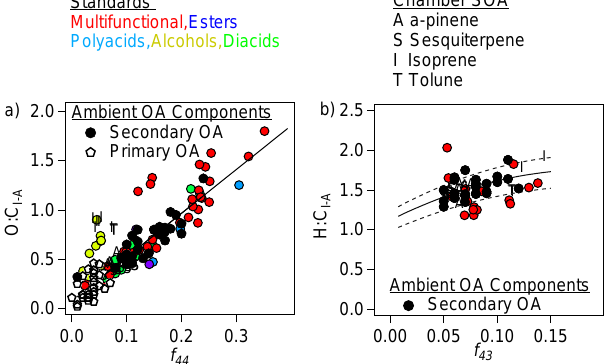
Figure 8. Scatterplot between Improved-Ambient O:C values and f 44 (fractional ion intensity at m/z 44 from unit mass resolution data). Ambient OA component data from field campaigns are shown as black points. The black line shows the linear fit through the am- bient OA (O:C I − A = 0 . 079 + 4 . 31 × f 44 ) . Chamber SOA and stan- dard OA data are also shown in the figure. (b) Scatterplot between Improved-Ambient H:C values and f 43 for ambient secondary OA components and chamber SOA. OA standard data is shown for the few multifunctional species which fit the criteria for this parame- terization ( f 44 >0.05 and f 43 >0.04). The solid line shows a scaled version of the Ng et al. parameterization (H:C Improved Ambient = ) and the dotted lines show ± 10% 1 . 12 + 6 . 74 × f 43 − 17 . 77 × f 2 43 deviations from the